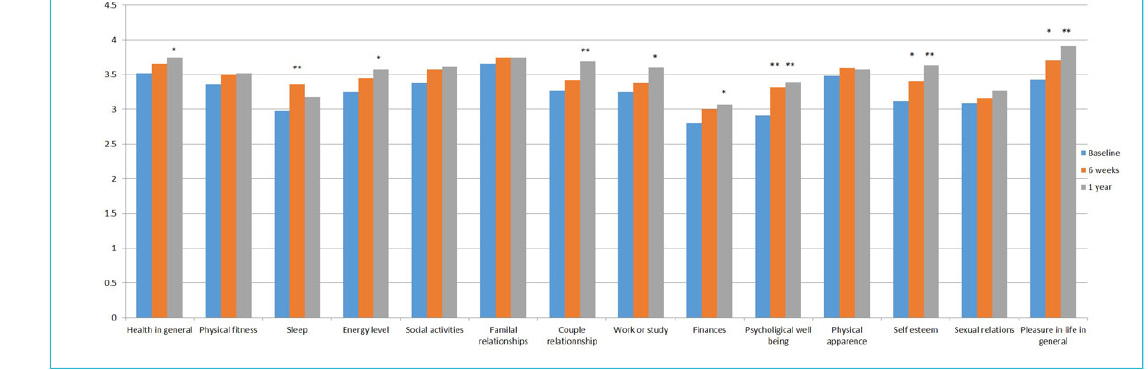
Figure 3: Quality of life at baseline and follow up. * p <0.05; ** p